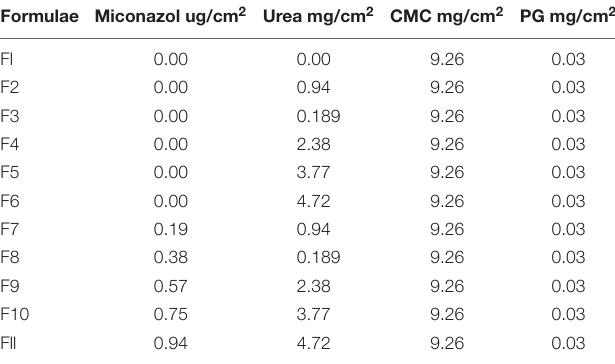
TABLE 2 | Composition of different formulae of water-soluble films.